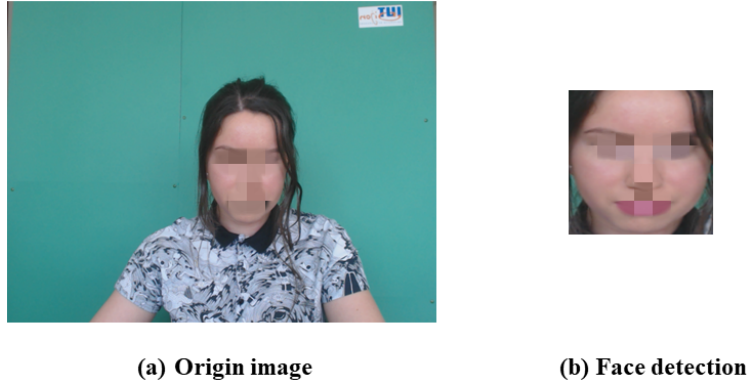
Figure 5. Face detection using MTCNN